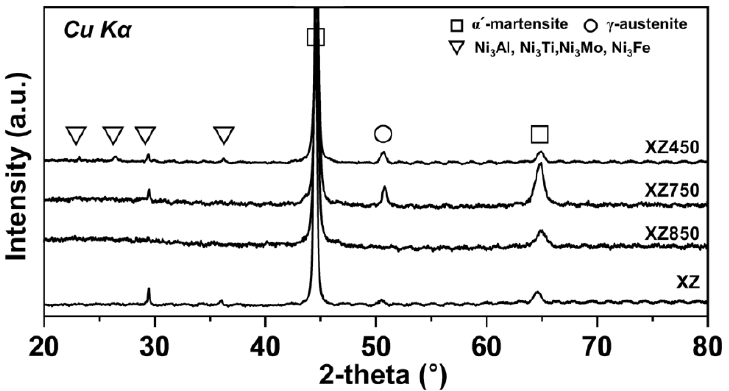
Figure 4. X-ray diffractometer diffraction (XRD) patterns of as-built state and heat-treated 18Ni300 MS.